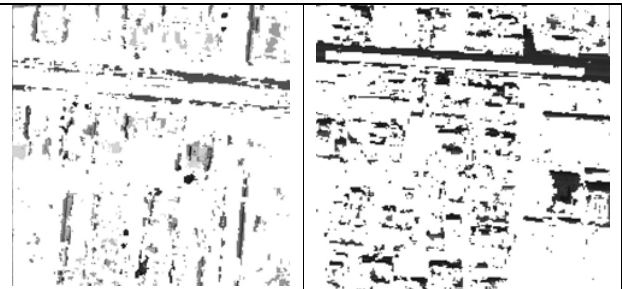
right image do not correspond at building facades due to different view direction. The limited values of the LSM correlation coefficients for the aerial photos with 63cm GSD